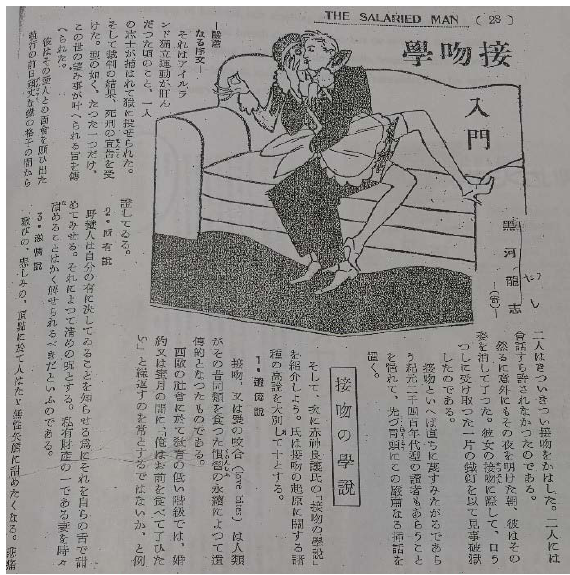
Figure 1. ‘The Art of Kissing,’ The Salaried Man , 1930, vol. 3, no. 7: